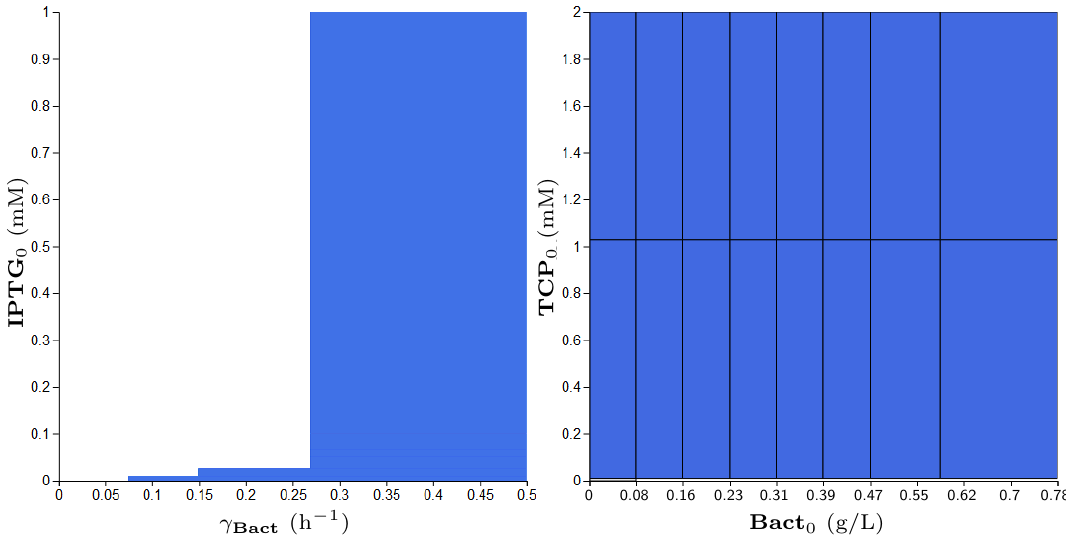
Figure 13. Results of parameter synthesis process for Property 5. Inside the figure, one can see two plots with blue regions. Both plots show a combination of parameters and (or) variables of the model where each point represents the particular evaluation of considered parameters (or variables). Every blue region represents a set of evaluations satisfying the stated property in at least one initial condition of the model. Here, the blue regions make joint projections across all non-displayed dimensions (i.e., parameters and variables). Consequently, the property holds in every combination of initial conditions (respectively, parameters) in the particular ranges.